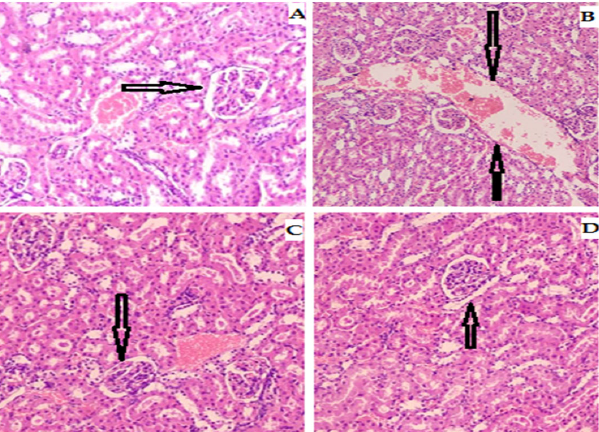
Figure 9. Photomicrographs of microsection of kidney of rat ( A ) control group showing the normal histological structure of renal parenchyma and bowman capsule, ( B ) diabetic group showing focal necrosis of epithelial lining renal tubules with architecture disturbance, ( C , D ) Rp ‐ Nc 0.5 mg and 1 mg treated groups showing slight hydropic degeneration along restoring histological structure of hepatic lobules, Rp ‐ Nc 1 mg treated group showing slight congestion along restoration of normal histological structure of histological structure of renal parenchyma (H & E scale bar 25 μ m). Rp ‐ Nc at dose concentrations showed some improvement in the architecture of renal capsule, nephrons and tubules and improvement in hepatic architecture towards normal. The photomicrograph of liver histopathology from normal control group revealed normal architecture in comparison to mild hydropic degeneration of hepatocytes in dia ‐ betic control group with mild necrosis and infiltration (Figure 10). Administration of